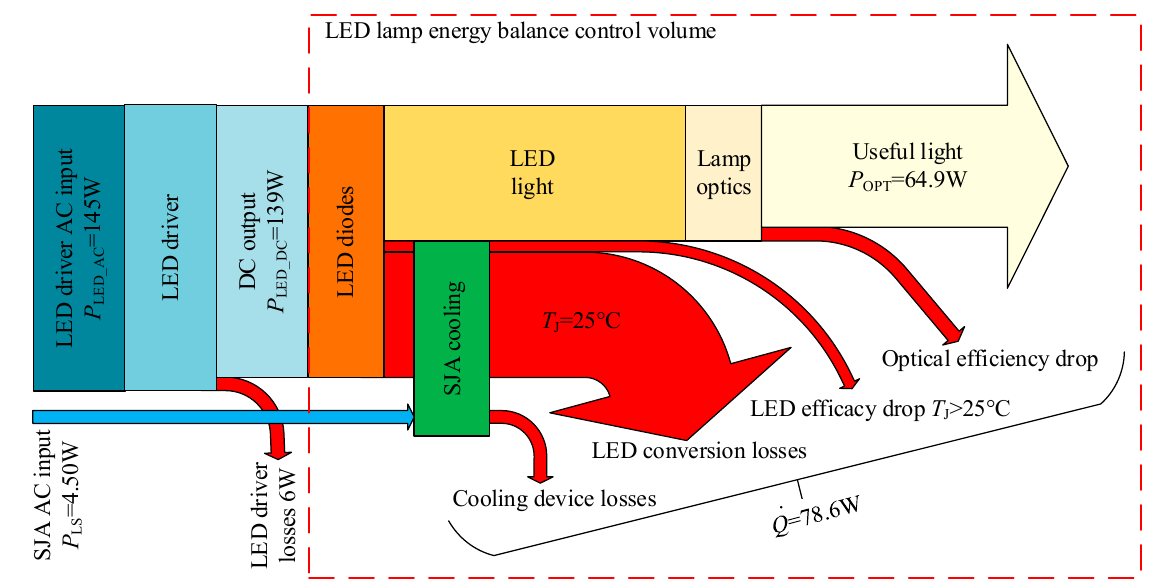
Figure 15. Energy conversion flow diagram of the LED lamp at P LS = 4.50 W.